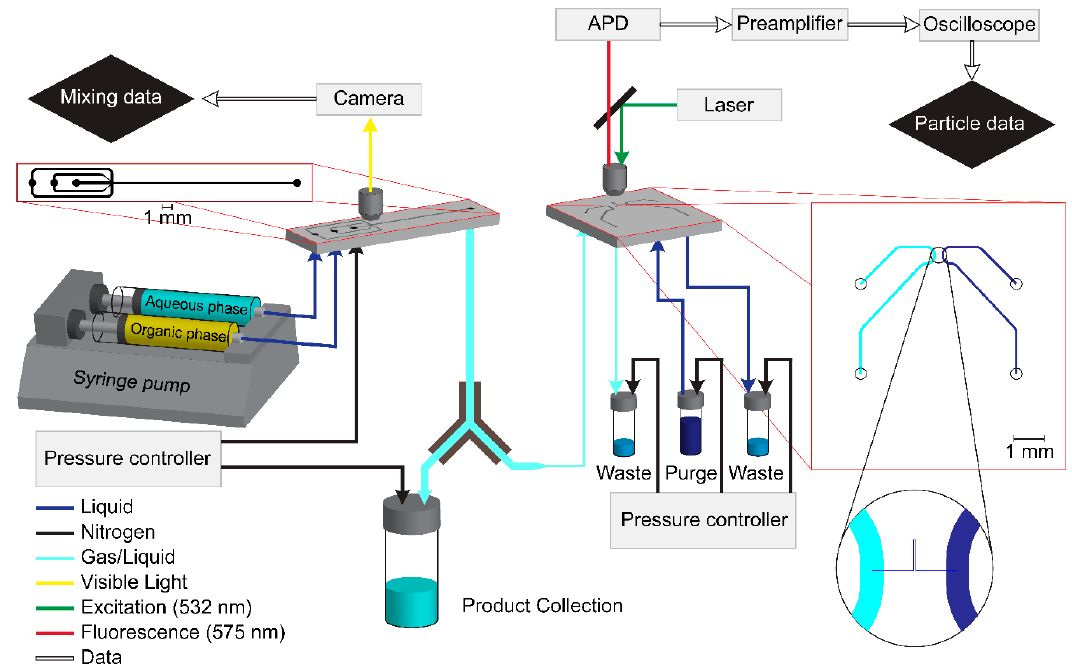
Figure 1. Flowchart and structure of the online analysis setup.